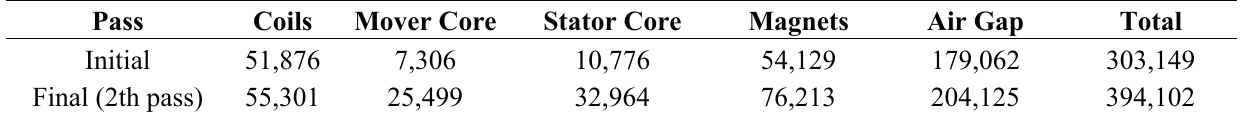
Table 3. Number of elements of 3D FEA Model.